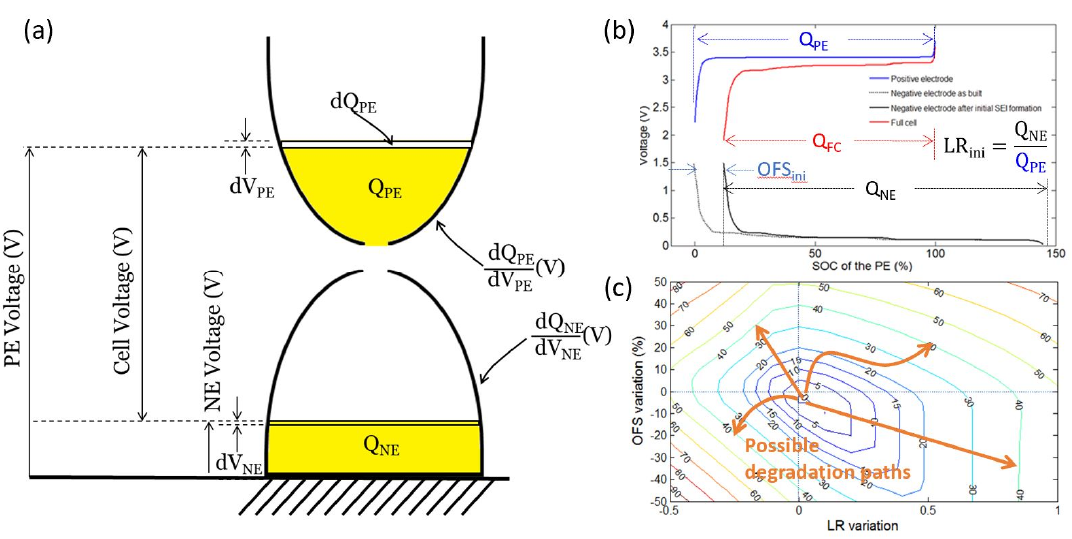
Figure 8. ( a ) Clepsydra analogy, ( b ) parameterization for mechanistic modeling, and ( c ) the e ff ect of changes of loading ratio and electrode o ff